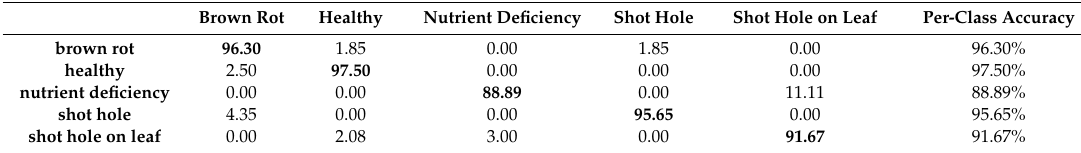
Table 5. Performance of various pre-trained CNNs fine-tuned on the dataset with data augmentation.